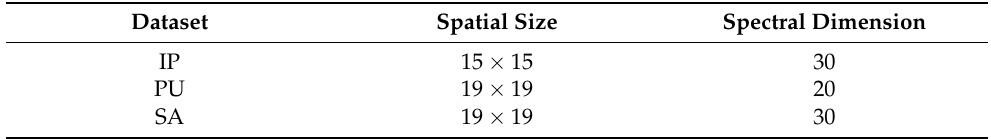
Table 5. The optimal spatial size and spectral dimension of the proposed model on three HSI datasets.